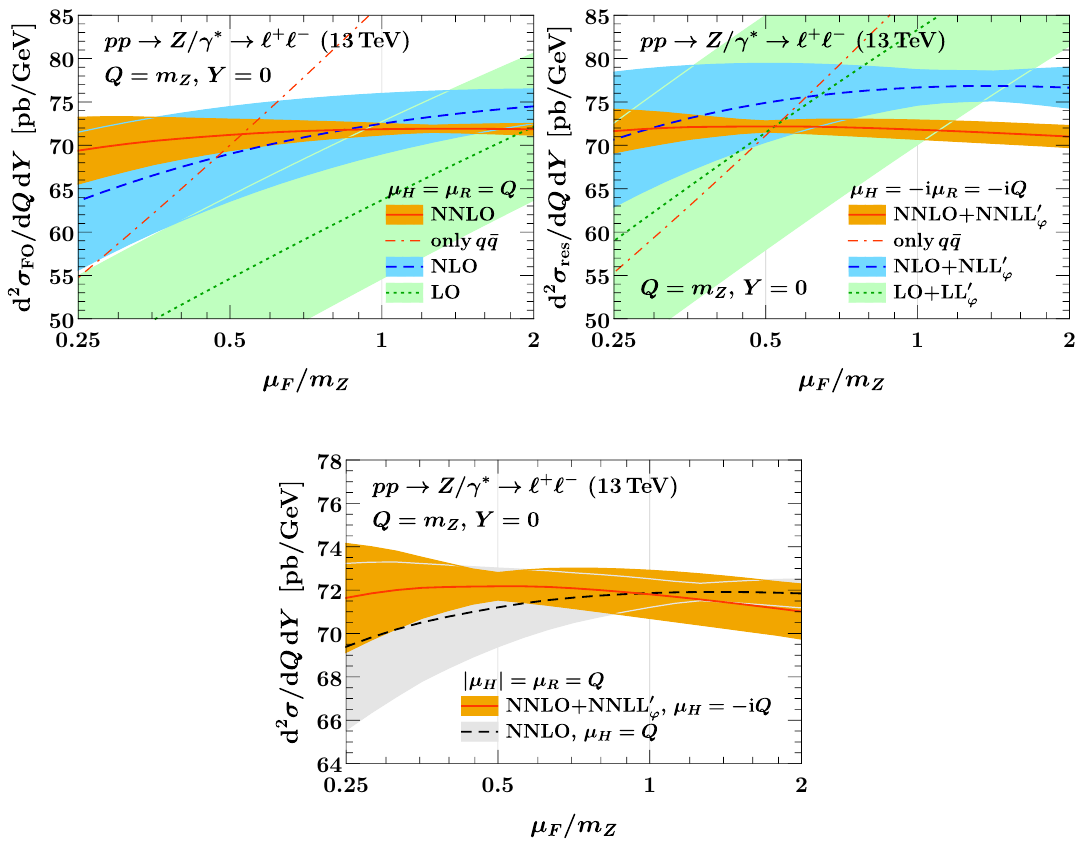
Figure 8 . Double-di(cid:11)erential cross section d 2 (cid:27)= d Y d Q for pp ! Z=(cid:13) (cid:3) ! ‘ + ‘ (cid:0) at Q = m Z and Y = 0 and for (cid:22) FO = (cid:22) R = m Z as a function of the central choice for (cid:20) F = (cid:22) F =m Z . The (cid:12)xed- order results are shown on the left and the resummed results on the right. For illustration, the dot-dashed line shows the contribution from the q (cid:22) q channel at the highest order. In the bottom panel, the highest-order results at NNLO and NNLO+NNLL 0 are directly compared with a further ’ zoomed-in y -axis. The uncertainty bands show (cid:1) (cid:22) ((cid:12)xed order) and (cid:1) (cid:22) (cid:8) (cid:1) ’